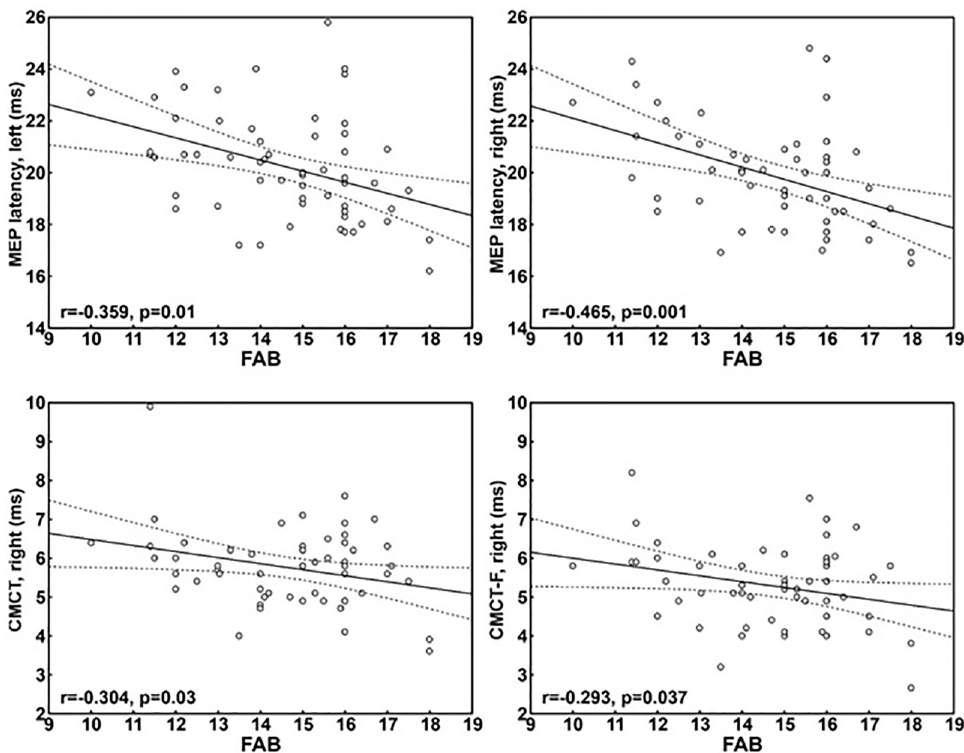
Fig 1. Correlation between FAB scores and TMS data. MEP = motor evoked potentials; CMCT = central motor conduction time; CMCT-F = central motor conduction time calculated through the F wave technique.